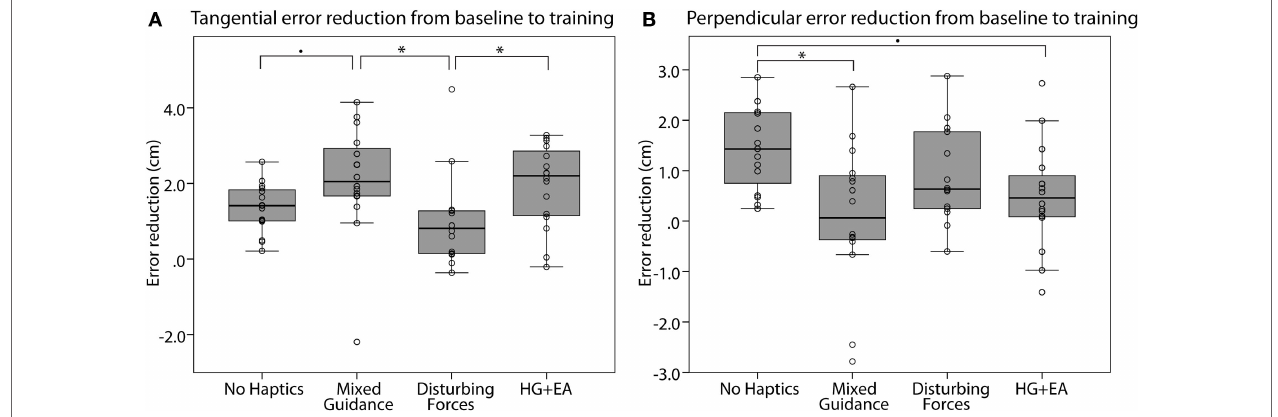
FIGURE 7 | Box-plot of error reduction from baseline to the first training block . (A) The robotic guidance provided in the tangential direction during training with mixed guidance and HG + EA reduced the mean absolute tangential errors in a greater amount than the no haptics and random disturbing forces. (B) The error amplification provided in the perpendicular direction during training with mixed guidance and HG + EA reduced the mean absolute perpendicular errors in a significant smaller amount than the no haptics and random disturbing forces. * p < 0.05, (cid:1) p < 0.1. Horizontal lines are medians, boxes show the interquartile range (IQR), error bars extent (cid:6) 1.5 IQR. Individual data points are plotted as circles.